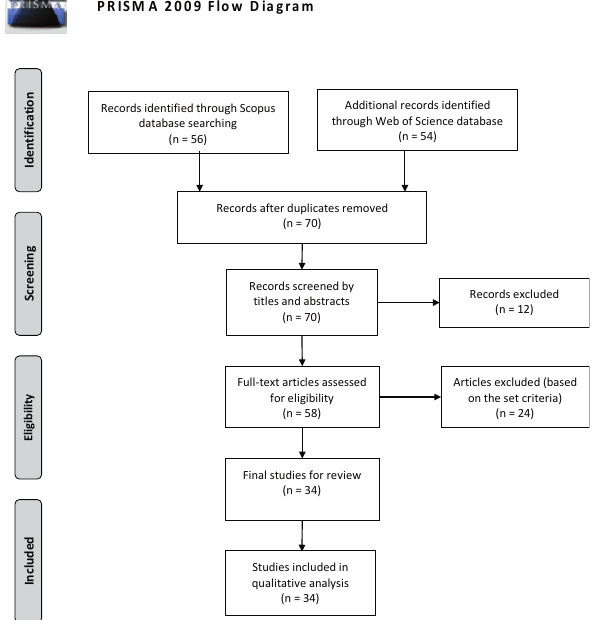
Figure 1. Prisma Flowchart filled with study results. Source: Moher et al.